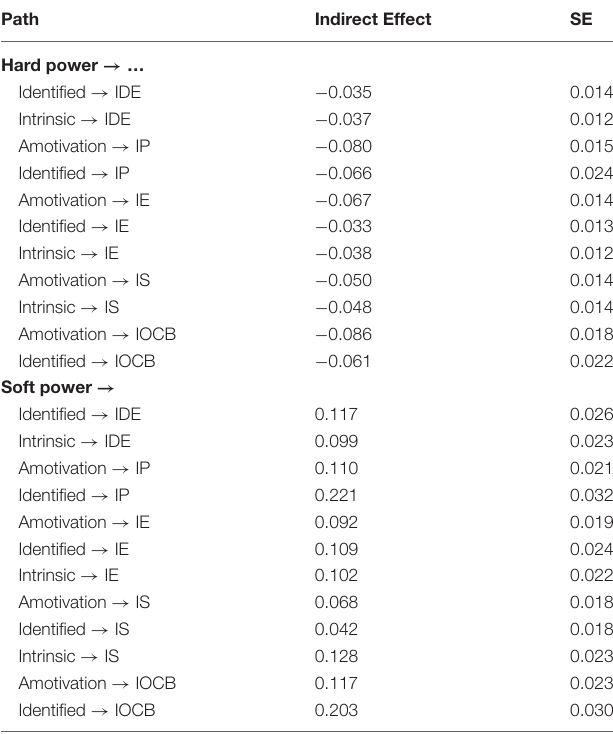
TABLE 6 | Summary of significant, specific indirect effects for Model 4 in Study 2.